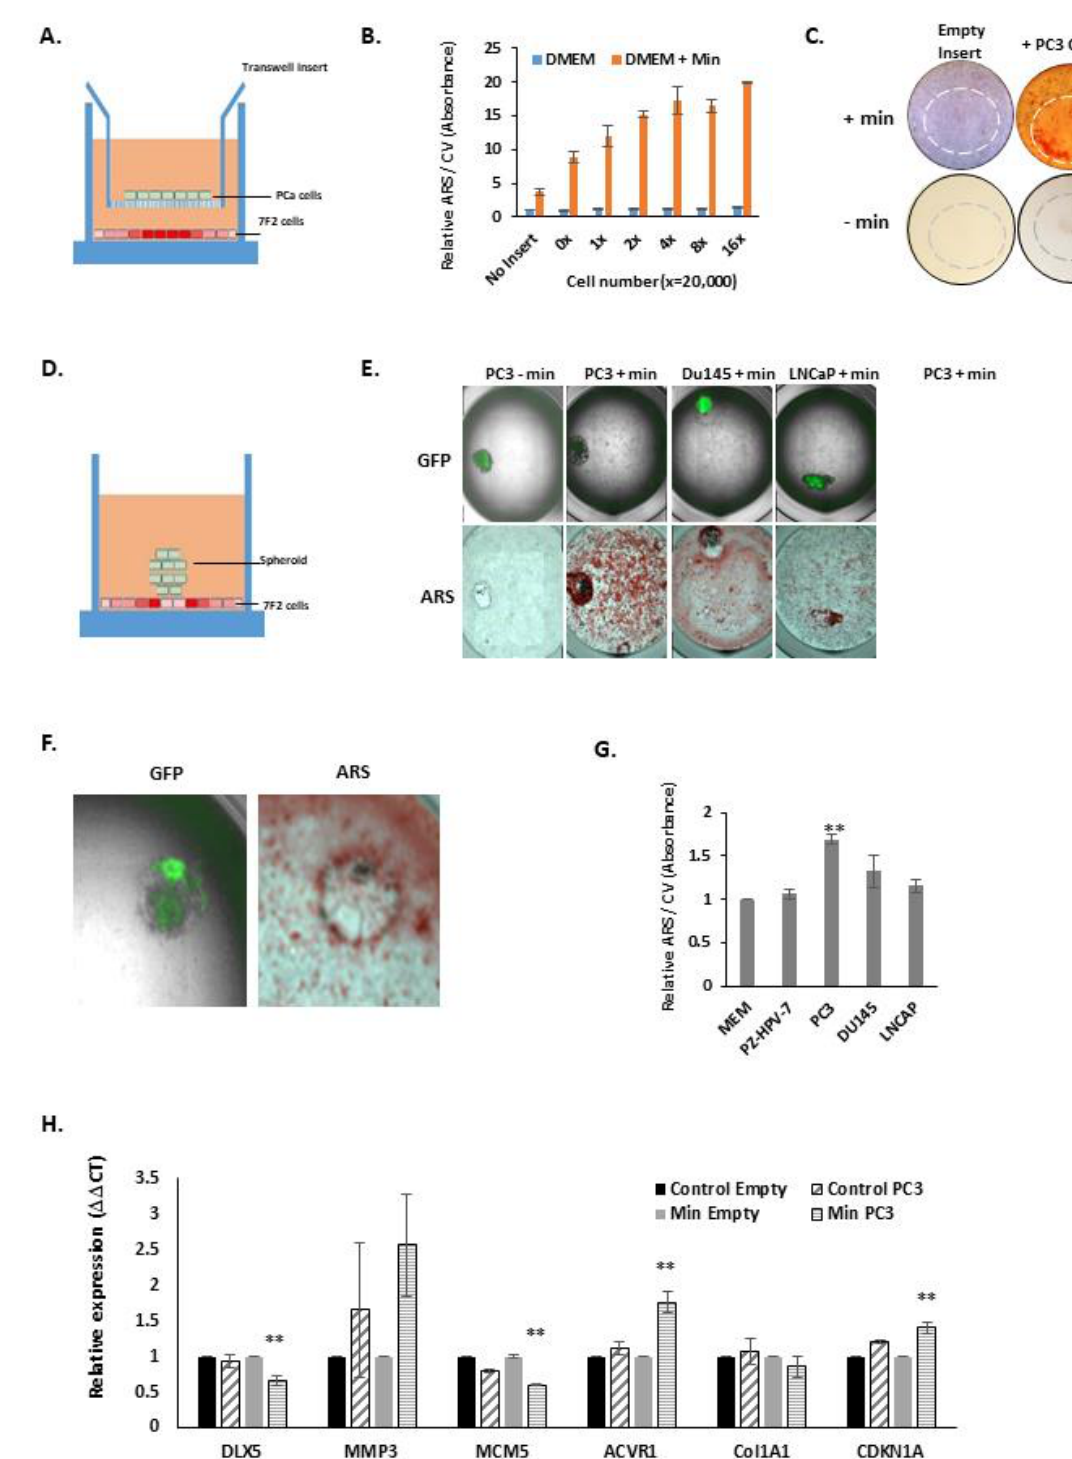
Figure 2. Prostate Cancer cells stimulate 7F2 Osteoblastic Mineralisation . ( A ), A schematic diagram of the cell co-culture system, including the transwell insert. ( B ), Alizarin red staining of 7F2 cells co-cultured with increasing numbers of PC3 cells either with or without osteogenic medium seeded in the co-culture insert. Graph shows alizarin red absorbance (405 nm) normalised to a post stain crystal violet (CV) stain (600 nm) for cell number. Graph shows average fold change from three independent experiments compared to 0 PC3 cells and no osteogenic media. ( C ), Images of the whole well of 7F2 cells stained with alizarin red after incubation with PC3 transwell insert with or without osteogenic media. Circle inset grey (hatched line) shows the outline of the insert in relation to the holding well. ( D ), A schematic of the spheroid-7F2 model. ( E ), Images